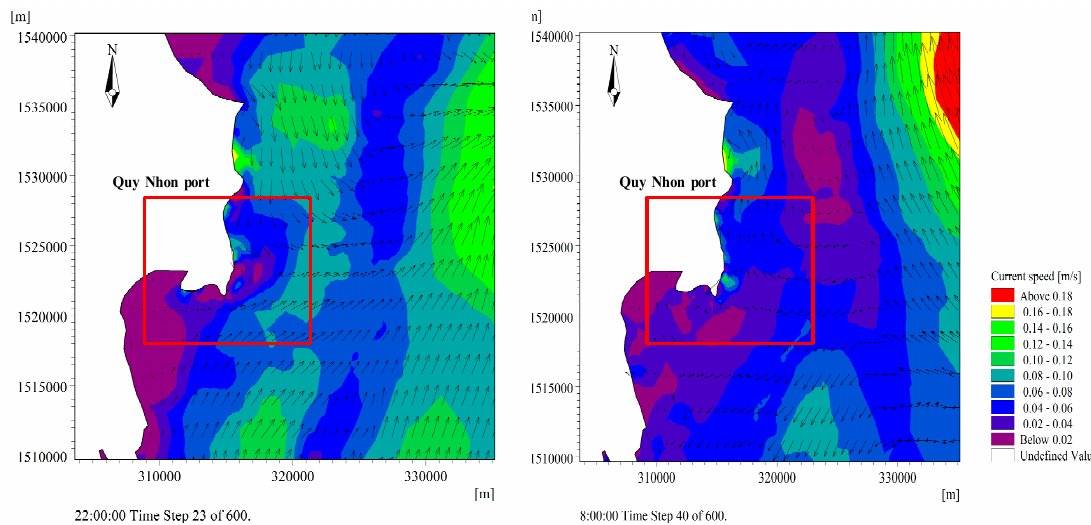
Figure 7. The flow field results at a closer view of Quy Nhon port.